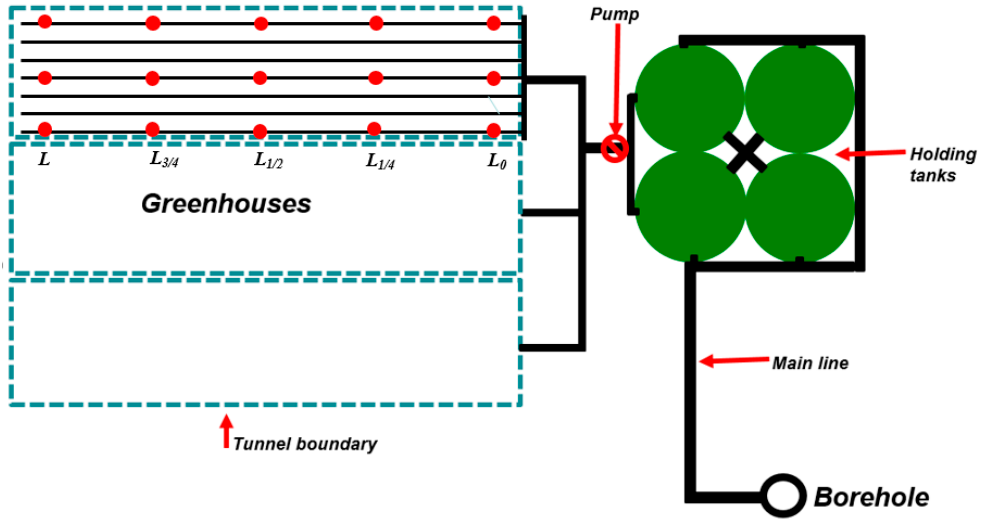
Figure 2. Schematic layout of an irrigation block at each Agri-Park. Dots on the drip lines are the emitter positions along the lateral lines.